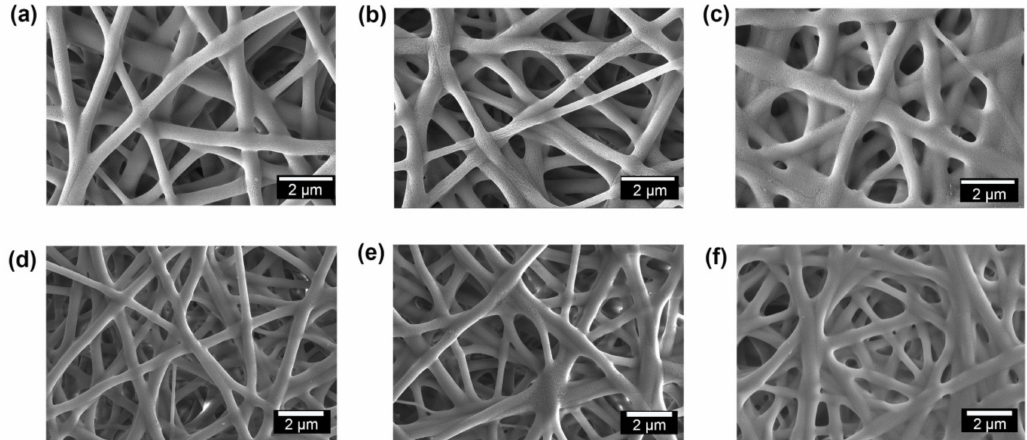
Figure 7. SEM images of the PU / FPU / TPU-50 nanofiber WB fabrics at di ff erent heat-treatment temperatures of ( a ) 100, ( b ) 120, and ( c ) 140 ◦ C. SEM images of the PU / FPU / TPU nanofiber WB fabrics at various TPU concentrations: ( d ) 25, ( e ) 50, and ( f ) 75 wt